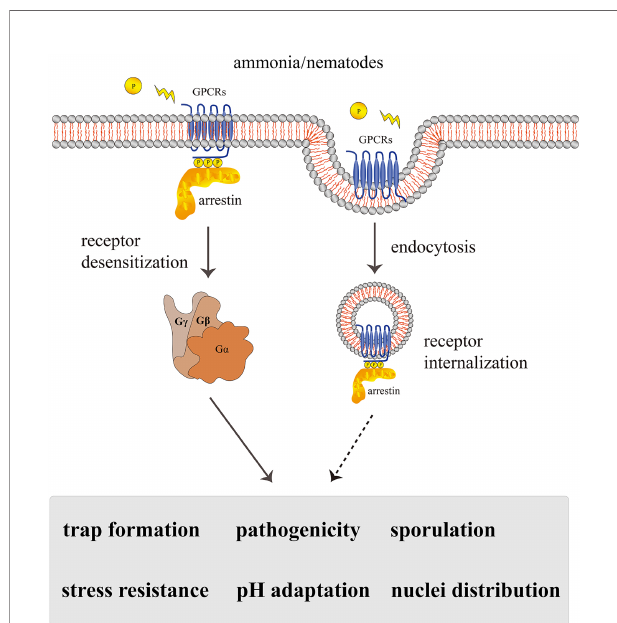
FIGURE 8 | A proposed model for the regulation of AoArc genes in Arthrobotrys oligospora . Arthrobotrys oligospora senses the nematode or ammonia stress signals and transmits them to G protein-coupled receptors in cells. Arrestin triggers various regulatory pathways by inactivating GPCRs and participating in endocytosis, thereby terminating G protein signals to regulate the series of biological processes including trap formation, pathogenicity, sporulation, nuclei distribution, pH adaptation, and stress resistance. The dashed arrow indicates the assumed connection; the solid arrow indicates the experimental